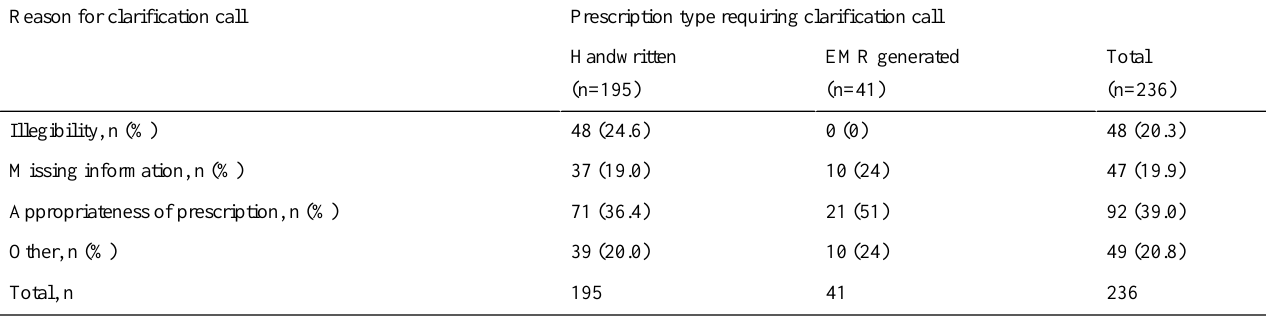
Table 3. Reasons for clarification